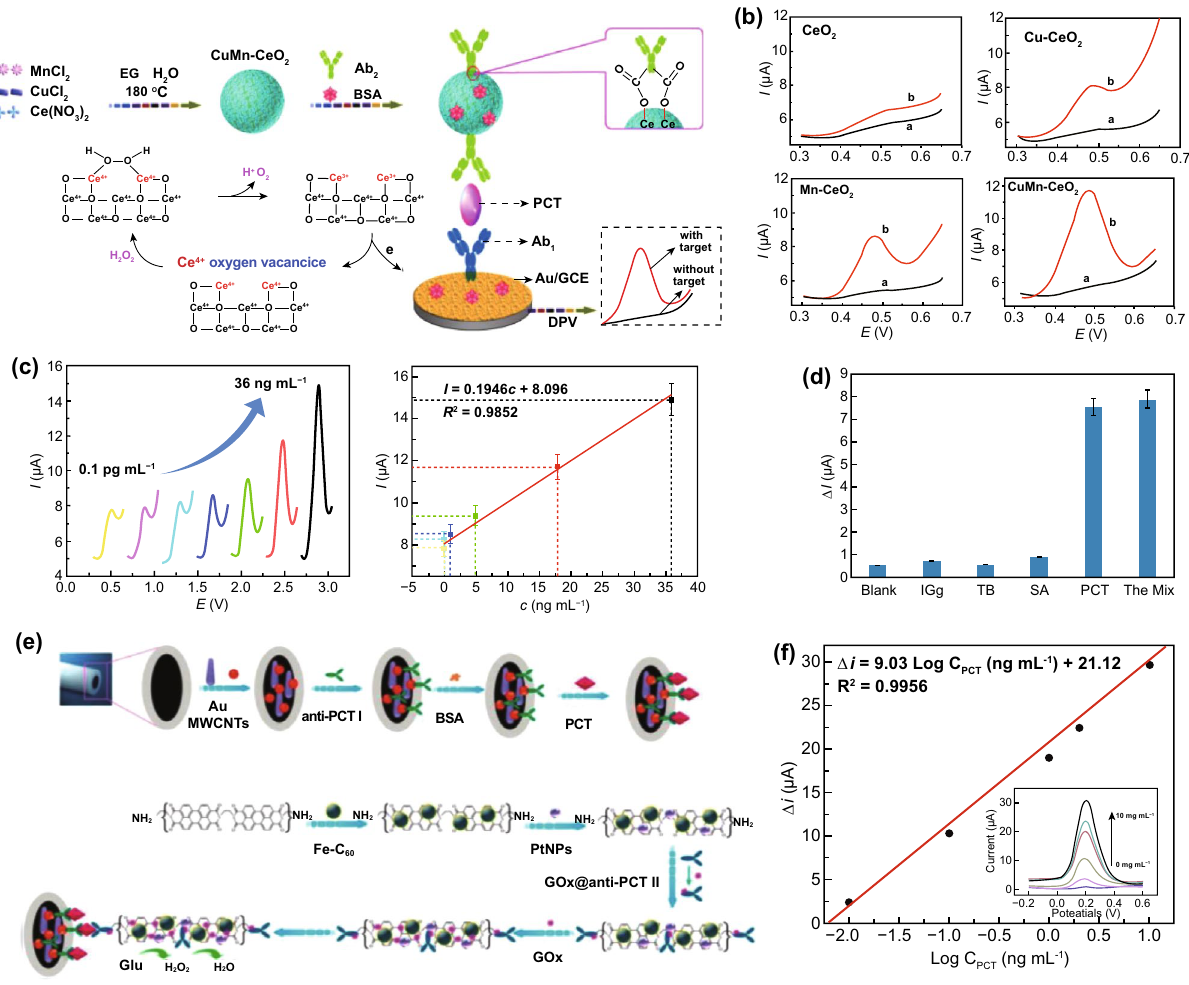
Fig. 8 Cu/Mn double-doped CeO 2 nanocomposites contributing to sensitive electrochemical detection of PCT via signal amplification. a Pro- posed mechanism of signal amplification provided by the CuMn–CeO 2 nanocomposite immunosensor for PCT detection. b DPV responses of the proposed immunosensor incubated with PCT using Ab2/BSA/CeO 2 , Ab2/BSA/Cu–CeO 2 , Ab2/BSA/Mn–CeO 2 or Ab2/BSA/CuMn–CeO 2 as a signal tag in the absence of H 2 O 2 (curve a) and in the presence of H 2 O 2 (curve b). c DPV responses of the CuMn–CeO 2 nanocomposite immu- nosensor after incubation with different concentrations of PCT (left), calibration curve of the intensity current of the immunosensor with Ab2/ BSA/CuMn–CeO 2 (right). d DPV current response of five samples detected by the CuMn–CeO 2 nanocomposite immunosensor for verifying the sensitivity of PCT detection. Reproduced with permission from Ref. [151]. Copyright 2017 American Chemical Society. C 60 carboxyfullerene- based functionalized nanohybrids for ultrasensitive electrochemical detection of PCT as a signal-amplifying tag. e Schematic illustration of the fabrication of the C 60 carboxyfullerene-based functionalized nanohybrid immunosensor and the corresponding catalysis amplifying principle. f DPV responses of the proposed nanosensor contribute to a favorable linear relationship with the logarithm of PCT concentrations. Reproduced with permission from Ref. [150]. Copyright 2015